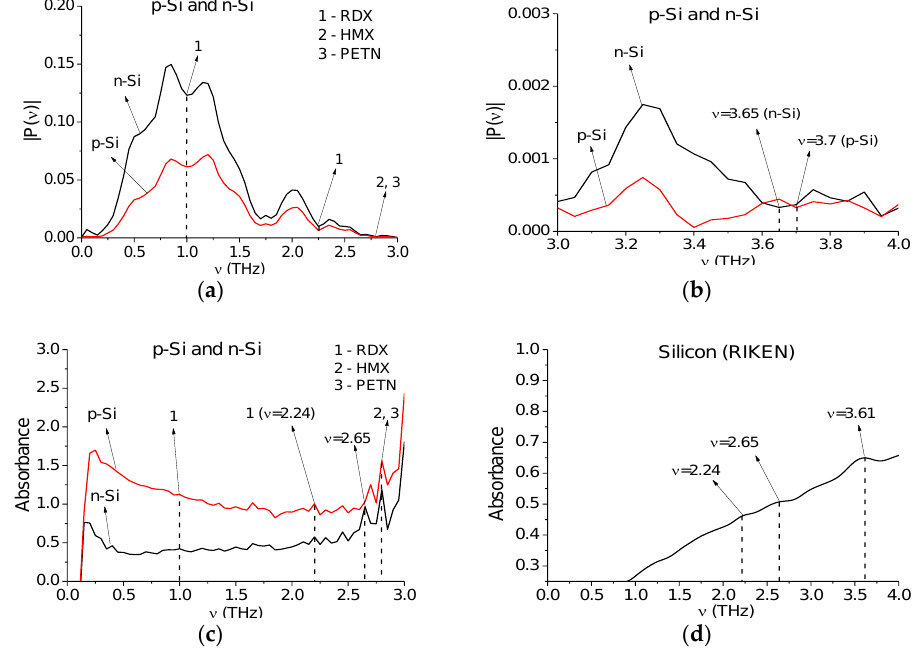
Figure 4. Fourier spectrum ( a , b ) and absorbance ( c ) of the n-Si and p-Si THz signals in the frequency ranges ν = [0.0, 3.0] ( a , c ); [3.0, 4.0] THz ( b ); absorbance of monocrystalline silicon in the frequency range ν = [0.0, 3.0] THz ( d ).